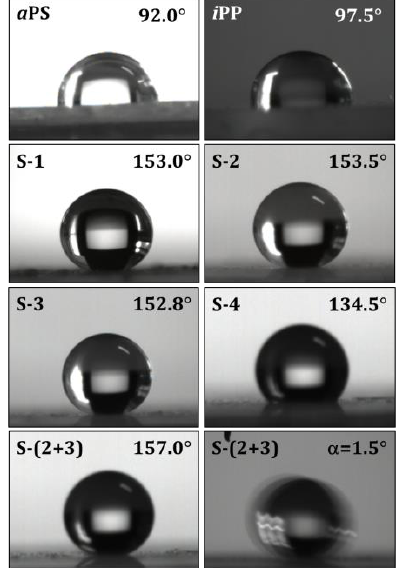
Figure 8. Contact angle of water drops on the surfaces cast from the i PP, a PS, and i PP / a PS miktoarm star copolymer solutions and the sliding angle ( α ) of the surface of the S-2 / S-3 mixture S-(2 + 3).